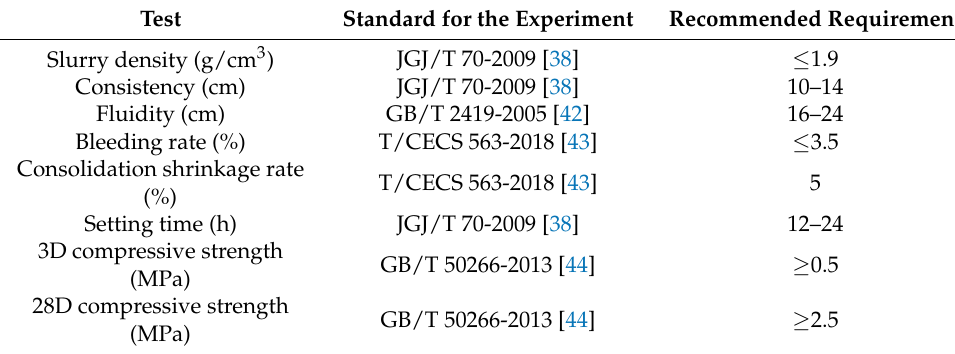
Figure 6. UCS for different rubber content without fiber. Table 5. Requirements for a grouting material.